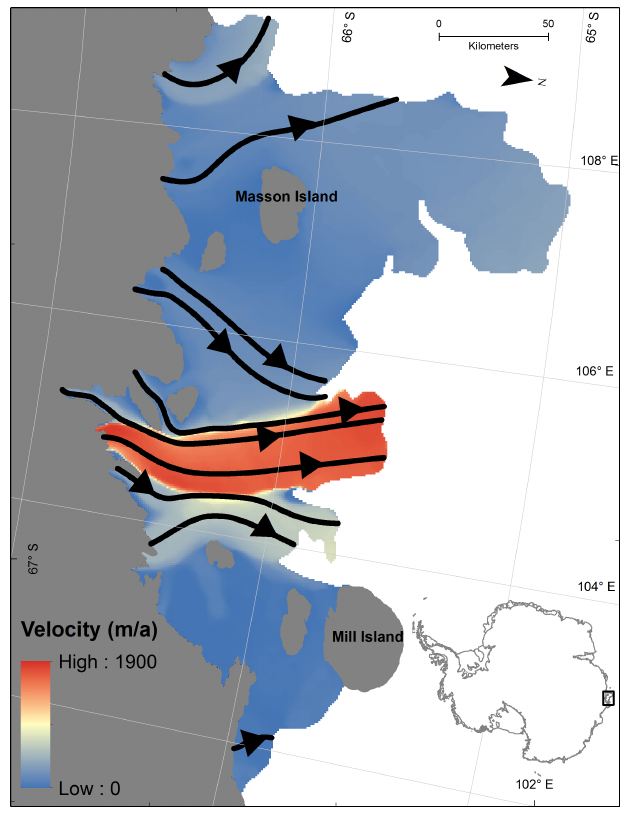
Figure 2. Map of Shackleton Ice Shelf. The background colors are flow velocities [31]. The bold black lines show the positions of the calculated flow lines and the arrows the direction of the flow. The grey areas represent the grounded portions (e.g., islands, inland ice), which were taken from Haran et al .